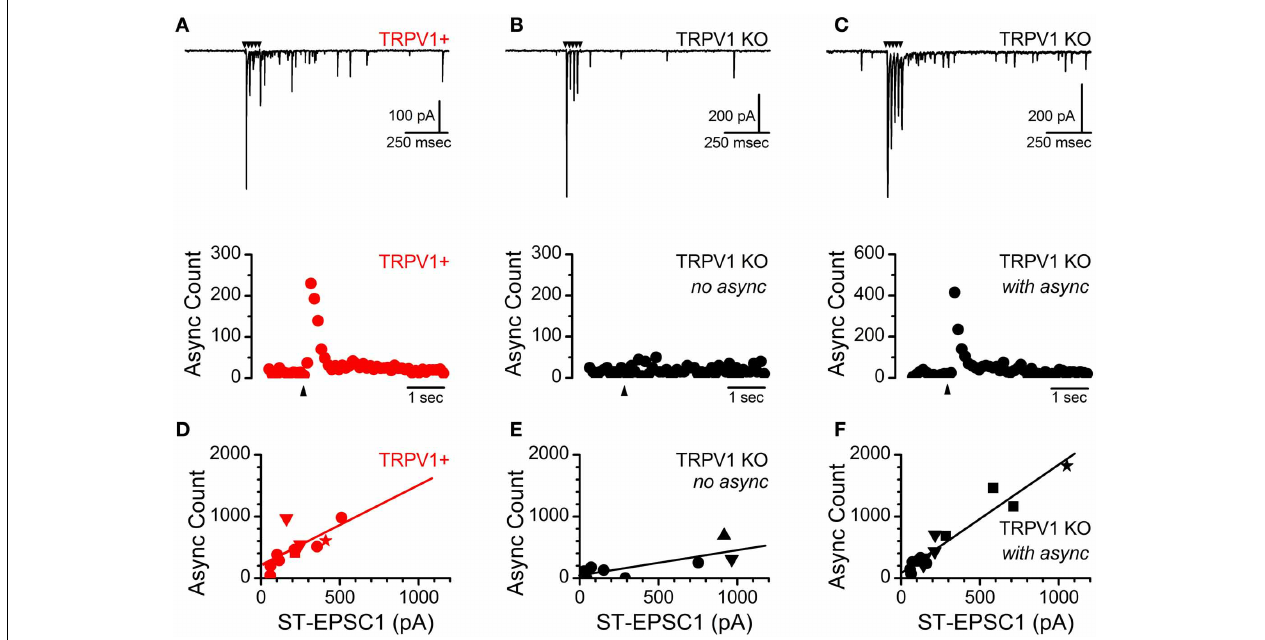
FIGURE 4 | Identification of a subpopulation of ST afferents from TRPV1 KO mice which maintain activity dependent asynchronous glutamate release. ( A , upper) Current trace showing ST driven synchronous and asynchronous release from an identified TRPV1 + afferents in control mice. ( A , lower) Histogram of summed asynchronous quantal glutamate events from across 50 trials. Black arrows indicate time of ST shock in all panels. ( B , upper/lower) Nearly half (6 of 13) of all neurons recorded from TRPV1 KO ST afferents showed no asynchronous release regardless of the size or number of direct ST inputs. (C , upper ) A significant population of TRPV1 KO afferents still mobilized vesicles via the asynchronous release pathway; with the magnitude and duration of additional release similar to the TRPV1 + afferents from control animals (C , lower ) . (D) The total number of asynchronously released vesicles